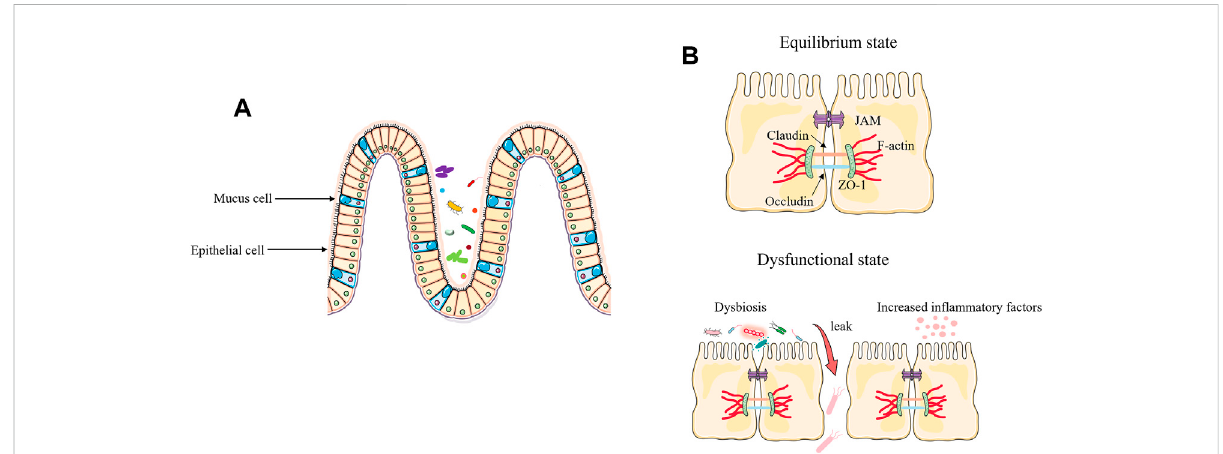
FIGURE 1 Disruptionoftheintestinalbarrierandthefunctionofthemicrobiotainsepsis. (A) Underhealthyconditions,theintestinalepitheliumconsistsof a single layer of intestinal epithelial cells (IECs), which is an important protective physical barrier that maintains intestinal homeostasis. (B) During sepsis, excessive release of in fl ammatory factors and loss of tight junction of epithelial cells leads to bacterial translocation and exacerbates the progression of